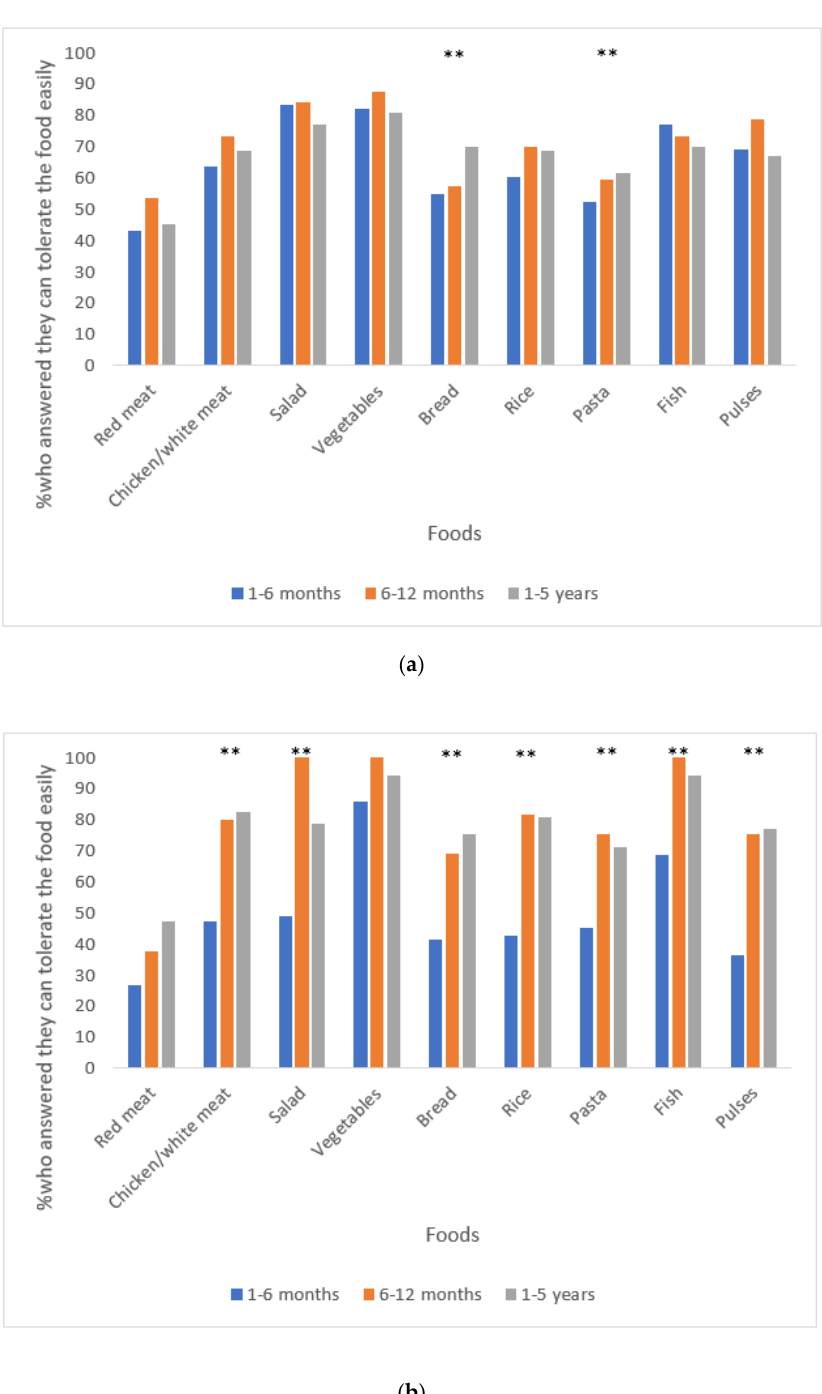
Figure 1. ( a ): Tolerance to different food items by time elapsed since surgery (Israel) 1,2,3 . ( b ): Tolerance to different food items by time elapsed since surgery (Portugal) 1,2,3 . 1 Data were available for participants from Israel and Portugal for n = 101 and n = 36 respondents between 1–6 months post-surgery, n = 56 and n = 16 respondents between 6–12 months post-surgery, and n = 104 and n = 52 respondents between 1–5 years post-surgery. 2 Patients were asked how they can eat each of the following food items (easily/with some difficulties/not at all). 3 Pulses (e.g., lentils, chickpeas, peas, beans) were added to the original questionnaire for quick assessment of food tolerance after bariatric surgery. ** Significant differences between groups divided by time elapsed since